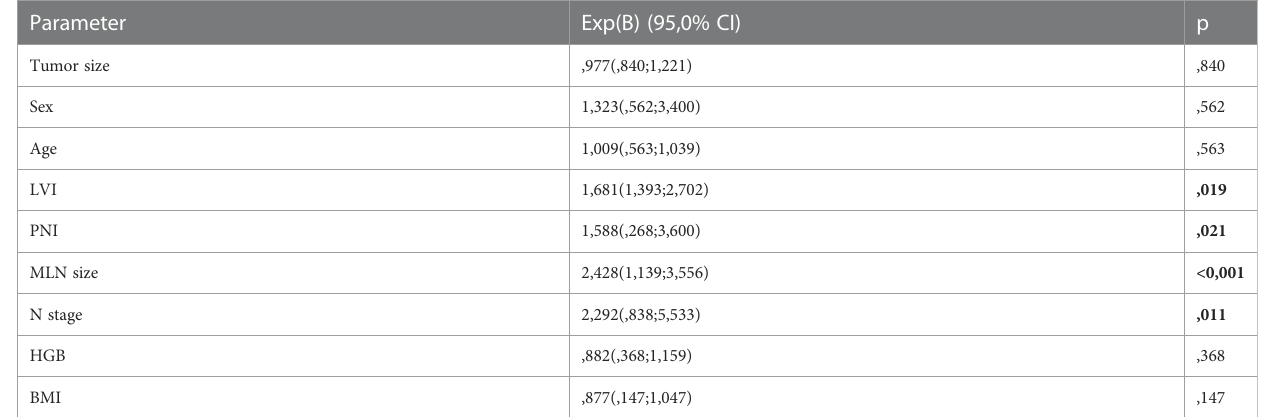
TABLE 2 Cox regression analysis of clinicopathological variables affecting mortality.